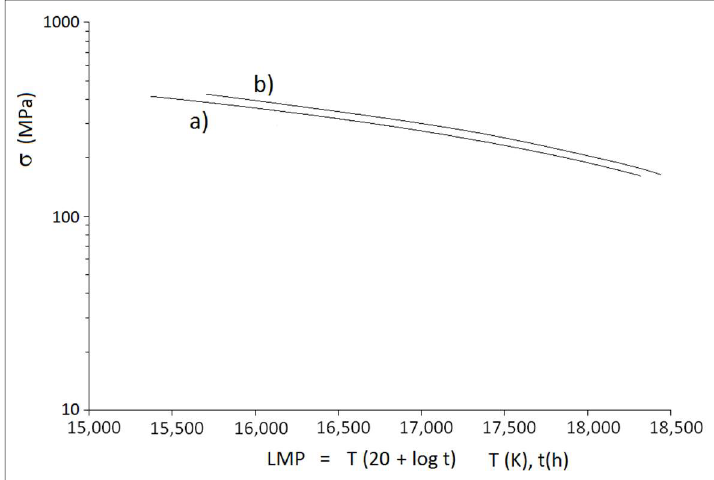
Figure 18. Larson Miller diagram for specimens A: ( a ) As-built specimen; ( b ) Smoothed specimen.